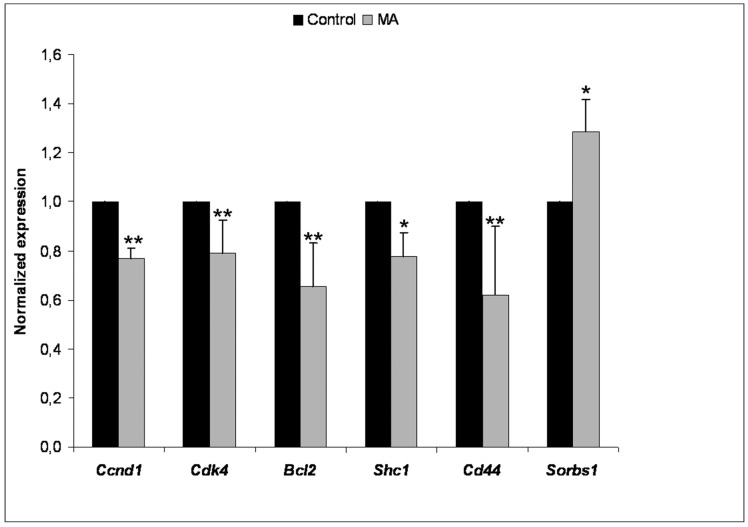
Validation of genes that were differentially expressed in the colon mucosa of ApcMin/+ mice after MA treatment by RT-PCR.Mean ± SD are shown. *, p<0.05; * *, **p<0.01, versus the untreated condition. n = 8/group.